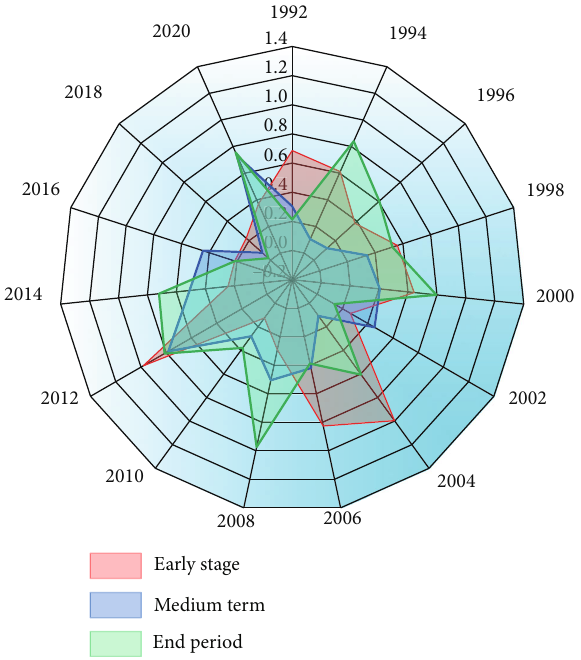
Figure 8: The amount of funds required for each stage of e- commerce